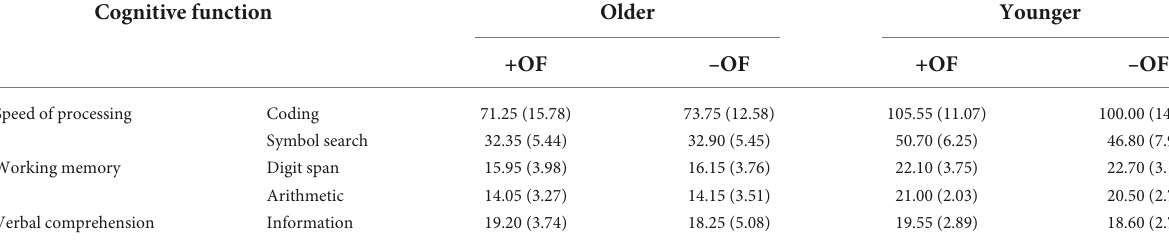
TABLE 1 Cognitive function of the older and younger groups. Cognitive